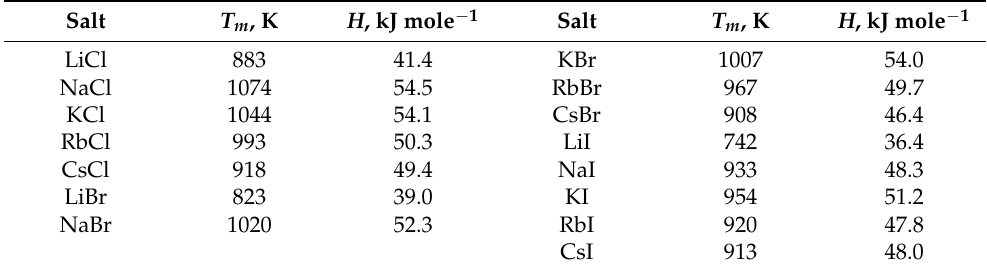
Table 4. Enthalpy ( H ) of solid halide salts before melting point ( T m ) [17].